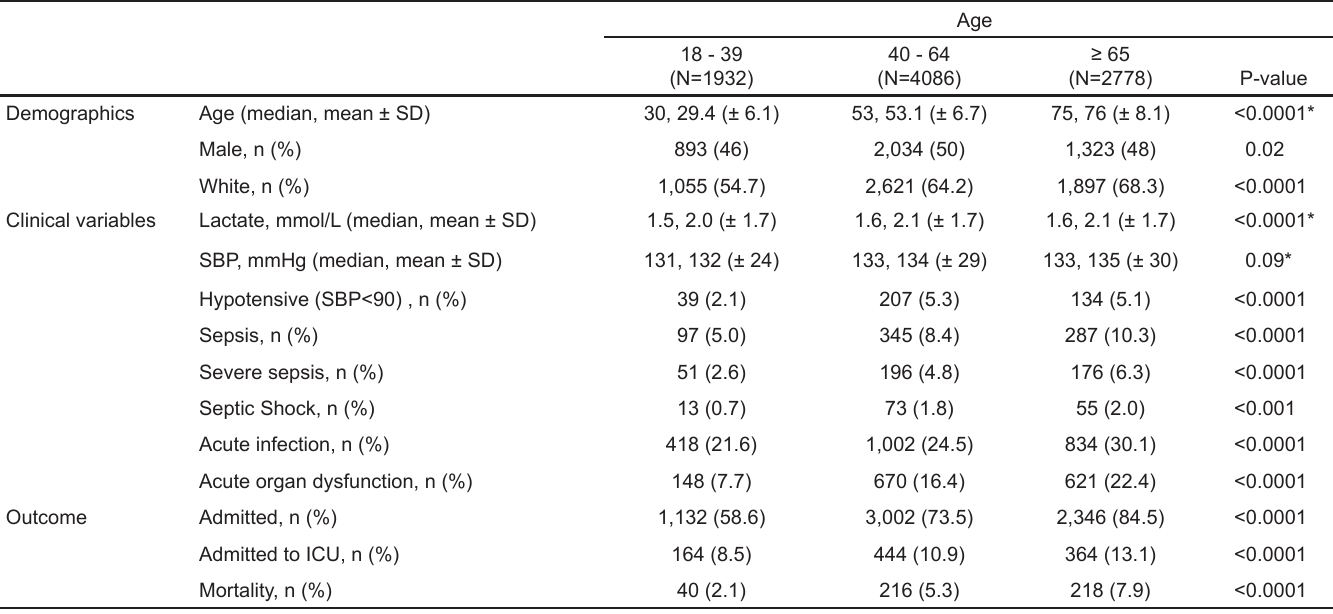
Table 2. Population characteristics by